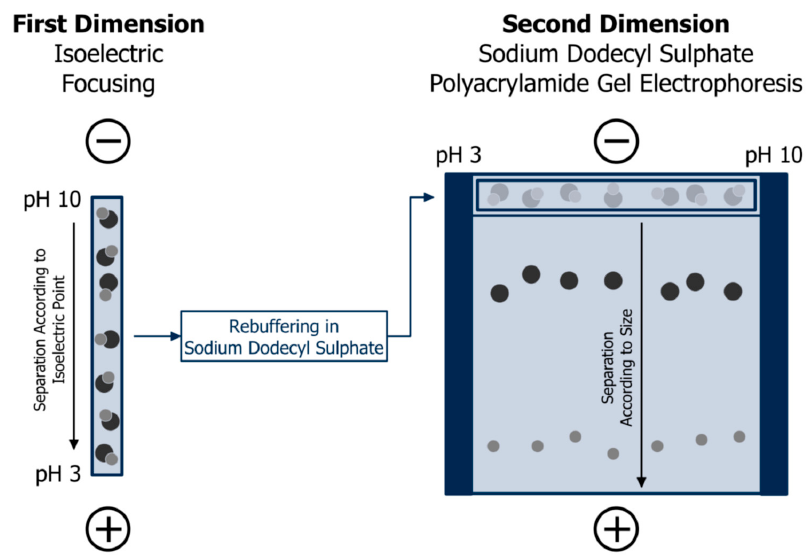
Figure 6. Principle of protein separation of two-dimensional gel electrophoresis: firstly, separation according to isoelectric points in a gel matrix with heterogeneous pH; secondly, size separation by sodium dodecyl sulphate polyacrylamide gel electrophoresis after equilibration in sodium dodecyl sulphate buffer. Adapted from [67], reproduced with permission from John Wiley and Sons, 2011.